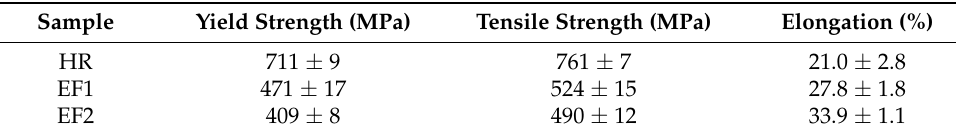
Table 2. Mechanical properties of HR, EF1, and EF2 samples.